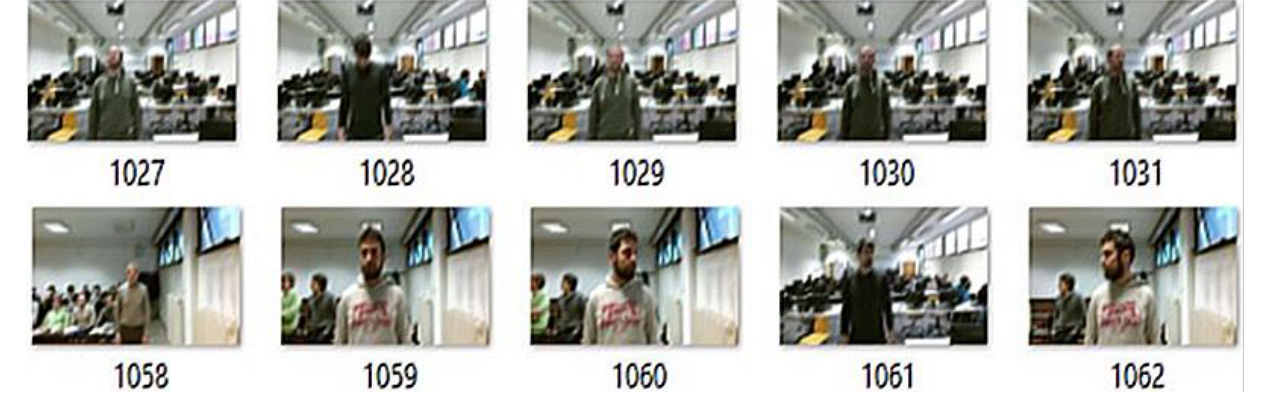
Figure 4. Merchant dataset sample images.